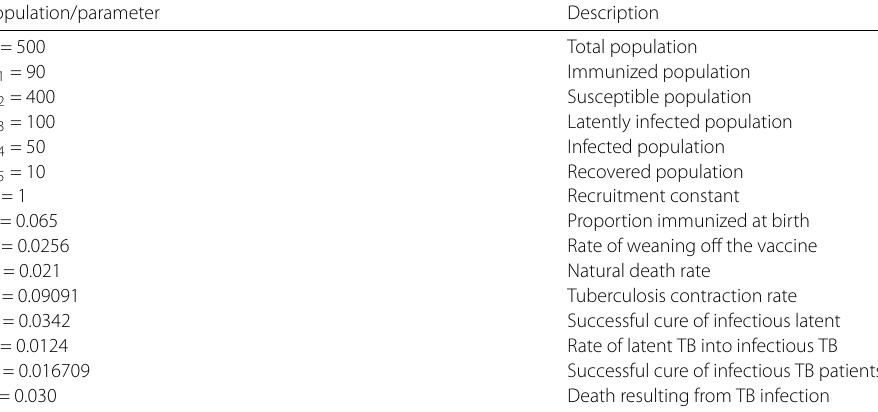
Table 1 Table of parametric values used for simulations of the problem under consideration